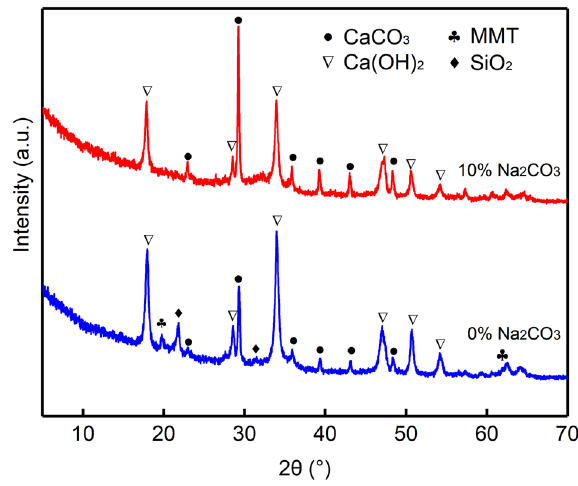
Figure 6. XRD patterns of 3:7 particles without Na 2 CO 3 and with 10 wt% Na 2 CO 3